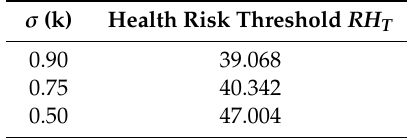
Table 6. Optimal predictive maintenance strategy under di ff erent σ